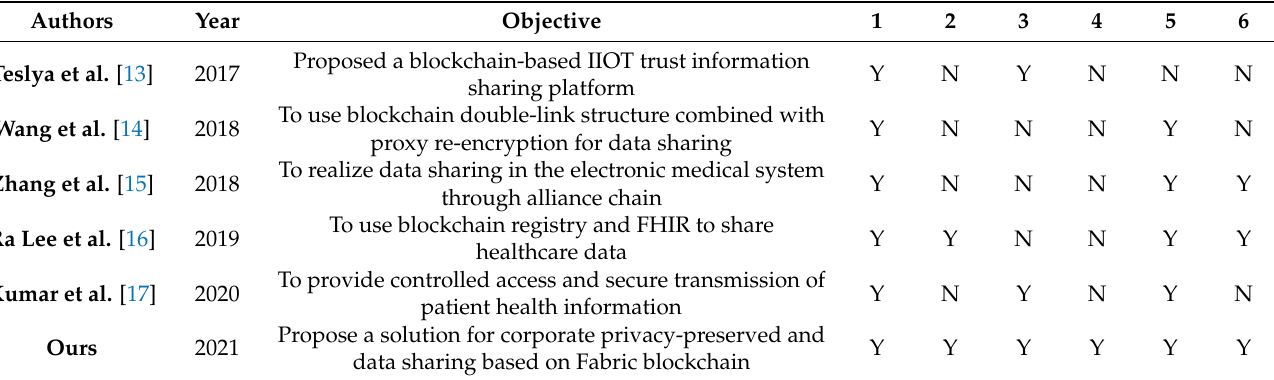
Table 7. Functionality comparison of previous schemes and the proposed